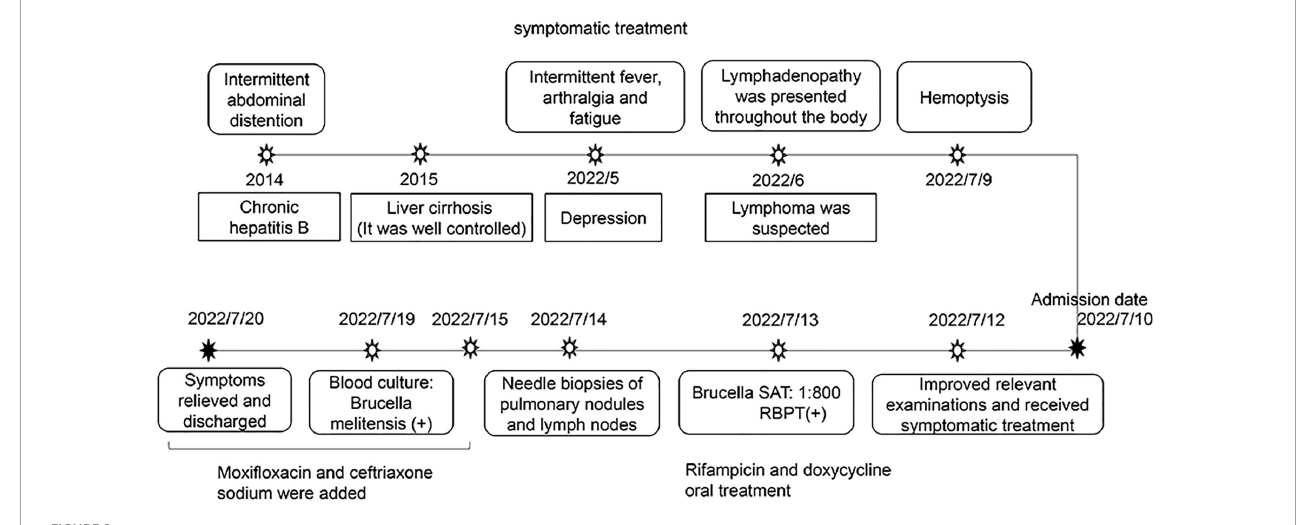
FIGURE2 The entire process of diagnosis, treatment, and outcome.